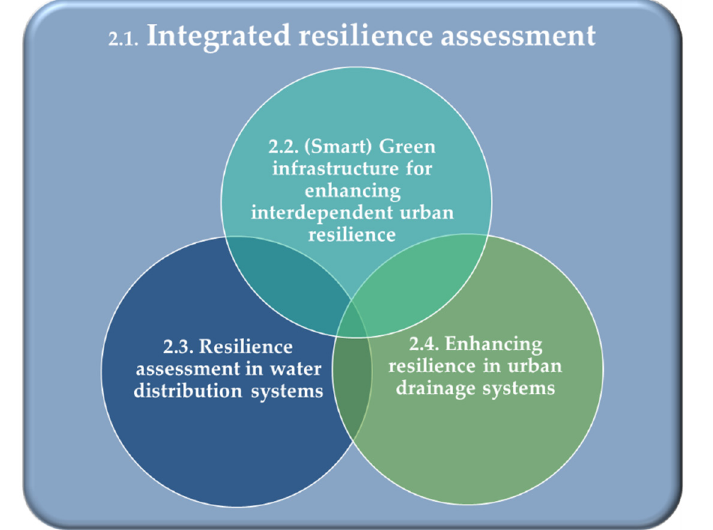
Figure 1. Sub-topics on the resilience of interdependent urban water systems tackled in this Special Issue.